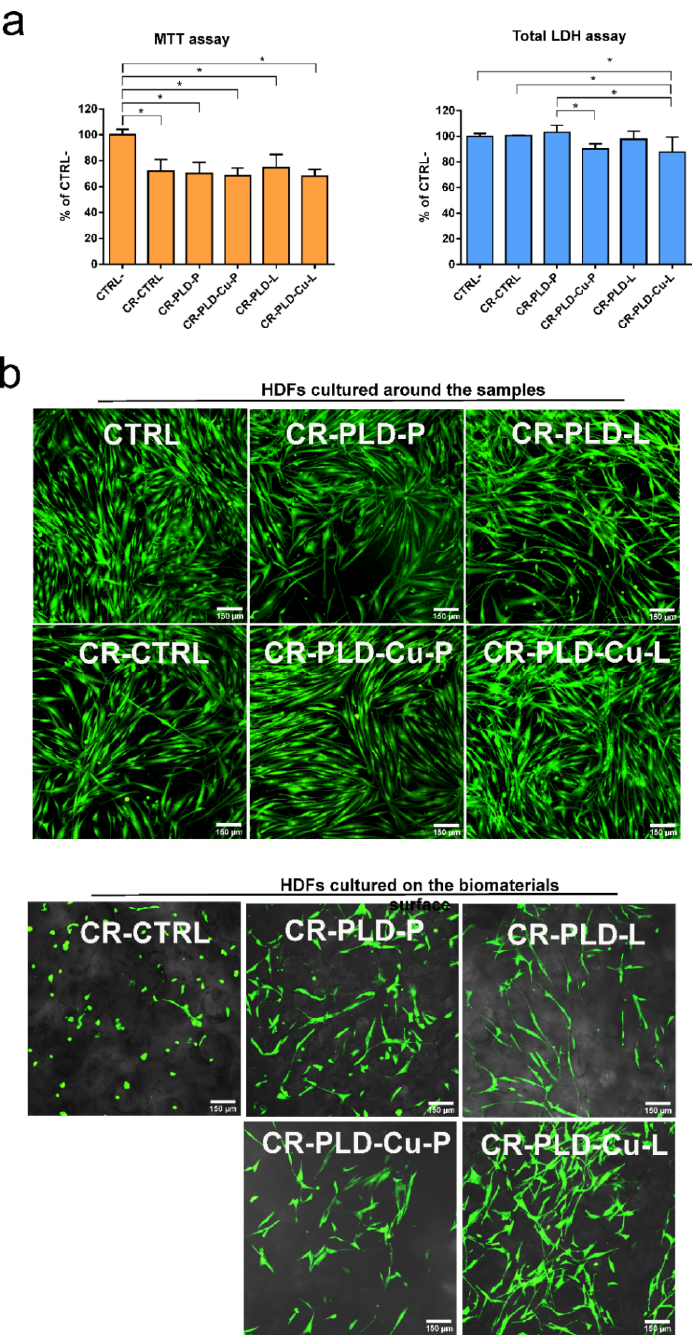
Figure 2. Cytotoxicity tests against human dermal fibroblasts (HDFs): ( a ) quantitative evaluation of cytotoxicity by MTT test (cell metabolism) and total LDH assay (cell number); CTRL − -negative control of cytotoxicity revealed 100% viability; * statistically significant ( p < 0.05) results between indicated group according to One-way ANOVA with post-hoc Tukey test; ( b ) qualitative evaluation of cytotoxicity by live/dead staining (green fluorescence-viable cells, red fluorescence-dead cells) followed by CLSM observation; CTRL-control cells grew on polystyrene